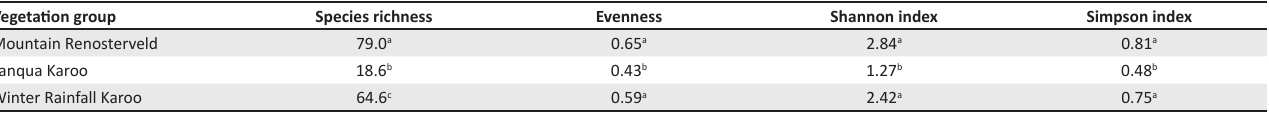
Within a column, values with the same superscript do not differ significantly at α = 0.05. TABLE 3: Mean species richness values for a range of plot sizes within three vegetation groups in the Hantam–Tanqua–Roggeveld subregion. Vegetation group Plot size